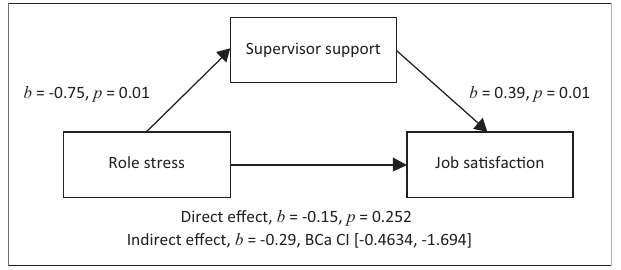
FIGURE 4: Graphing the interaction effects of role stressors and supervisor support in the prediction of job satisfaction.